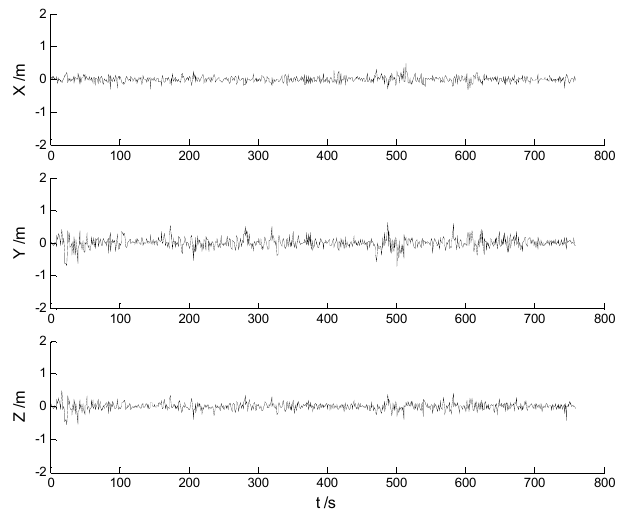
Figure 7. Position errors of the NMHF-CKF algorithm.